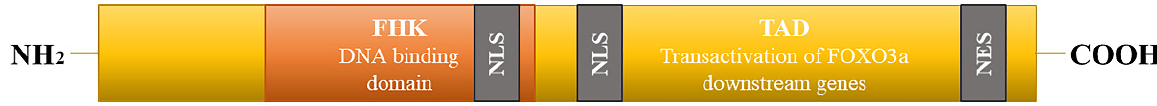
Figure 1. Structure of the FOXO3 protein. FHK: forkhead winged helix-turn-helix DNA binding domain; NLS: nuclear localization sequence; TAD- C: C-terminal transactivation domain; NES: nuclear export sequence.